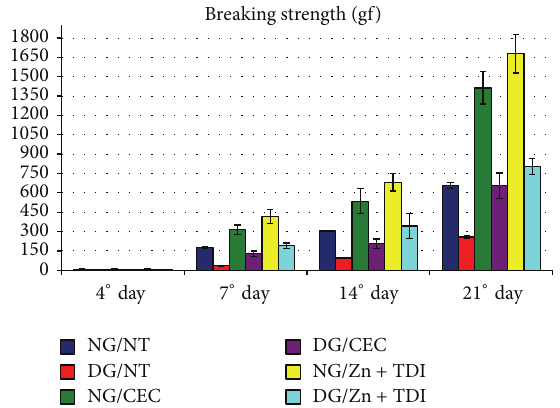
Figure 7: Variation in breaking strength values (gf) of scars produced in the skin of rats in the 6 experimental groups sacrificed at the 4 experimental